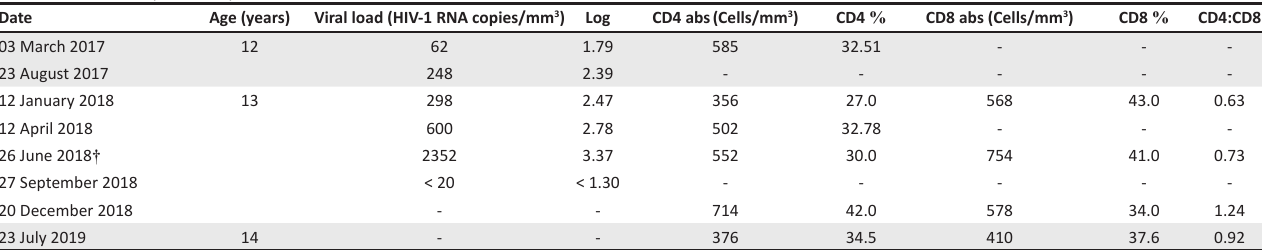
TABLE 3a: Laboratory data for patient